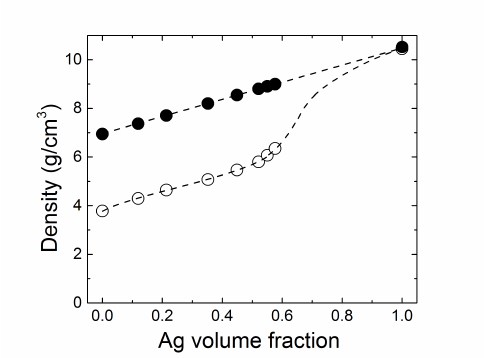
Figure 4. Theoretical (filled symbols) and experimental (open symbols) densities of composite Ag-LaCoO 3 pellets. The theoretical density values were calculated for ideally dense pellets. The experimental densities were determined after heat-treatment at 1000 ◦ C. The dashed lines are guide to